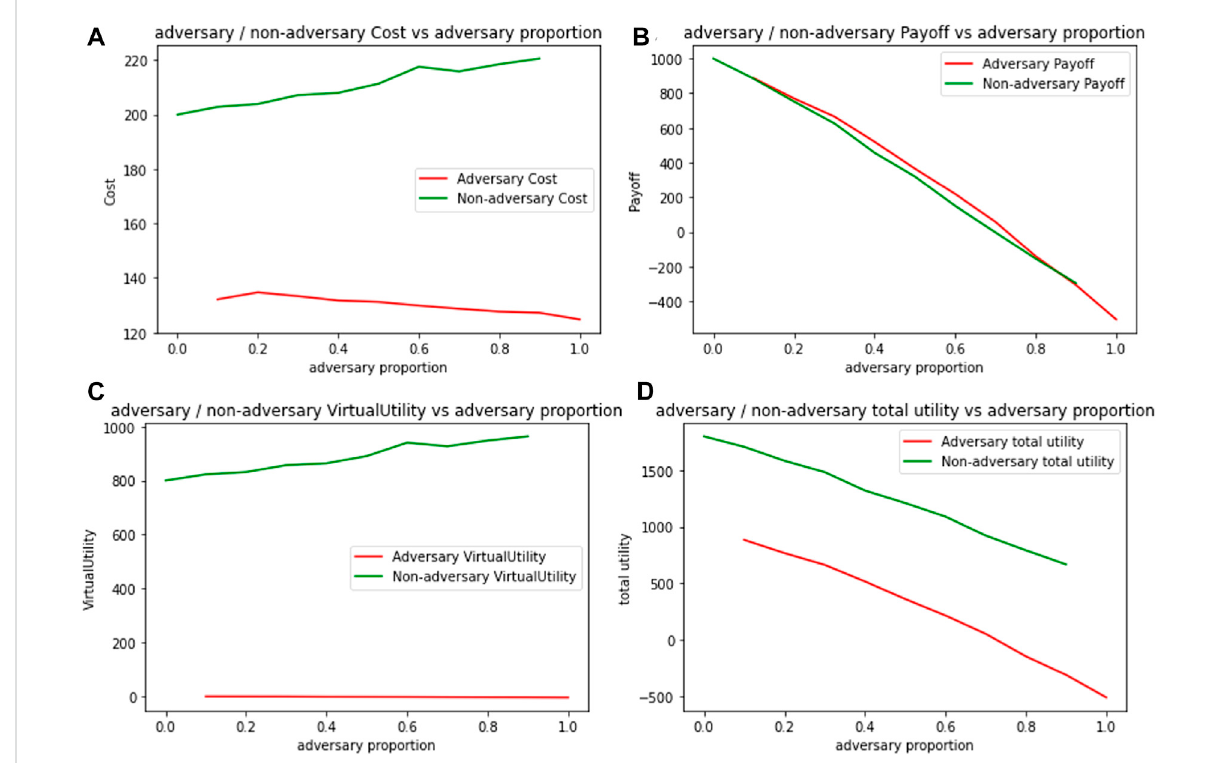
FIGURE 9 Expectedmetricsper100packetsforadversarialandnon-adversarialagentsbyvaryingadversaryproportion (A) Cost (B) Payoff (C) VirtualUtility (D) Total Utility.